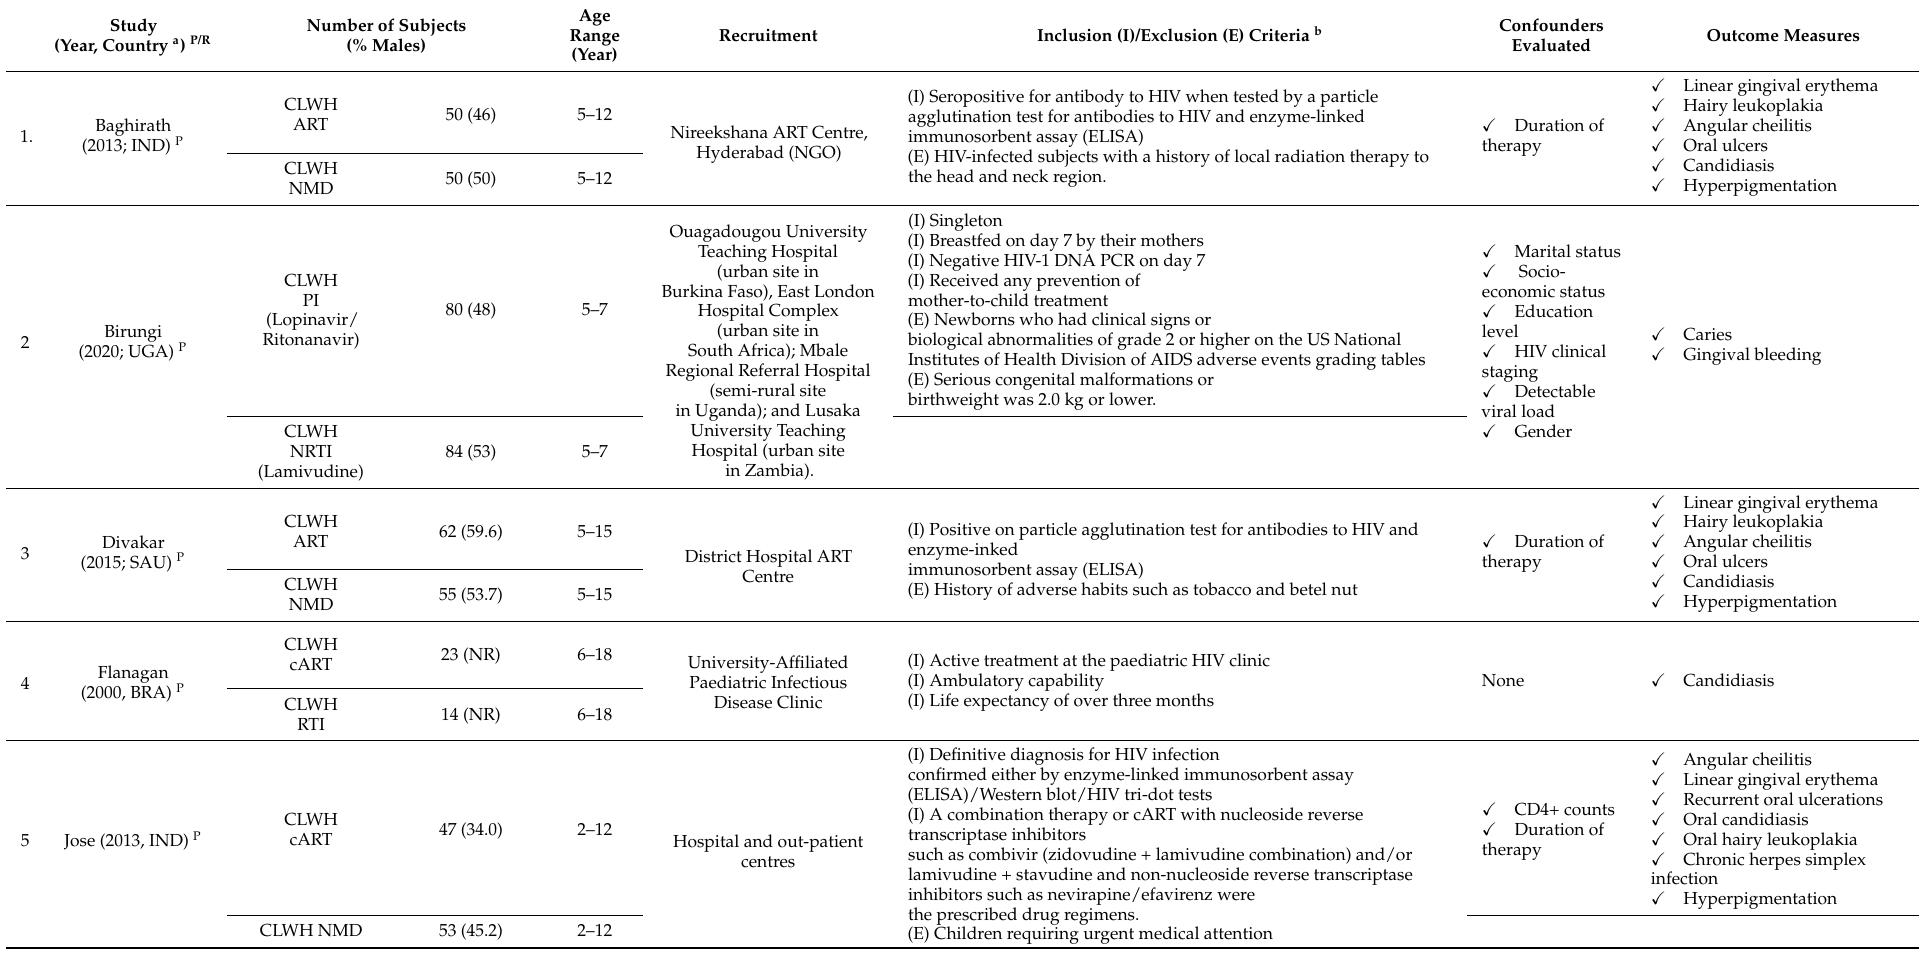
Table 1. Characteristics of included